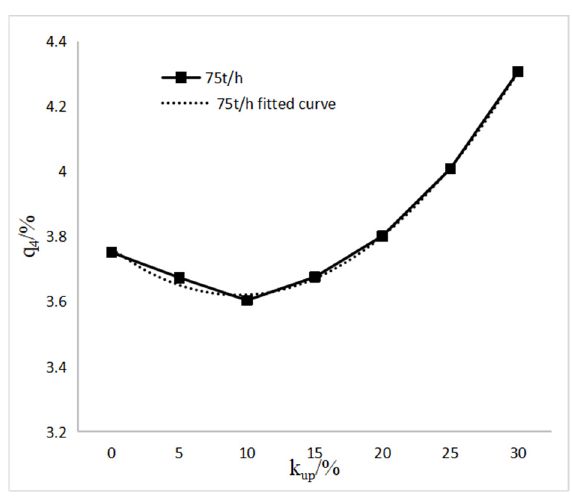
Figure 12. Influence of k up on q 4 .